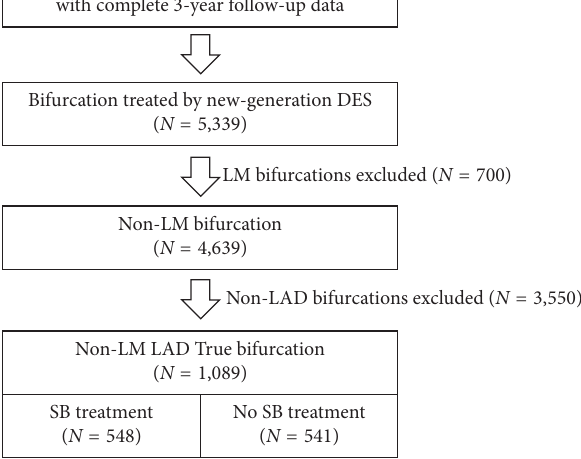
Figure 1: Study design. DES, drug-eluting stent; LM, left main coronary artery; LAD, left anterior descending coronary artery; ACEF, age, creatinine, and ejection fraction score; SB, side-branch; Tx,